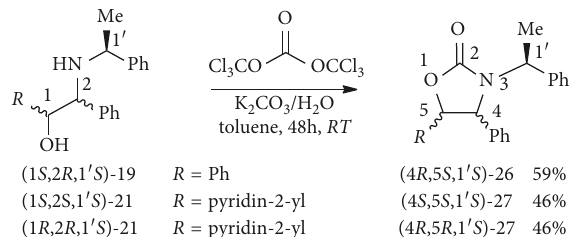
Figure 2: Structures and selected 1 H NMR (400 MHz, CDCl resonances of oxazolidinones 26 and 27